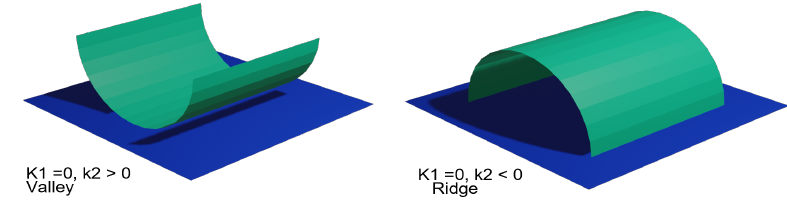
Figure 4. Principal Curvature values of the valley ( left ) and ridge ( right ) surfaces.